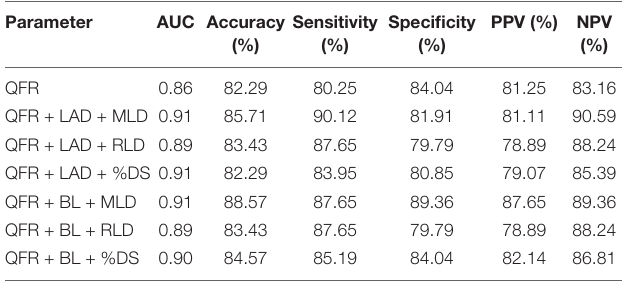
TABLE 5 | Logistic regression model with two lesion parameters added to QFR. Lesion parameters